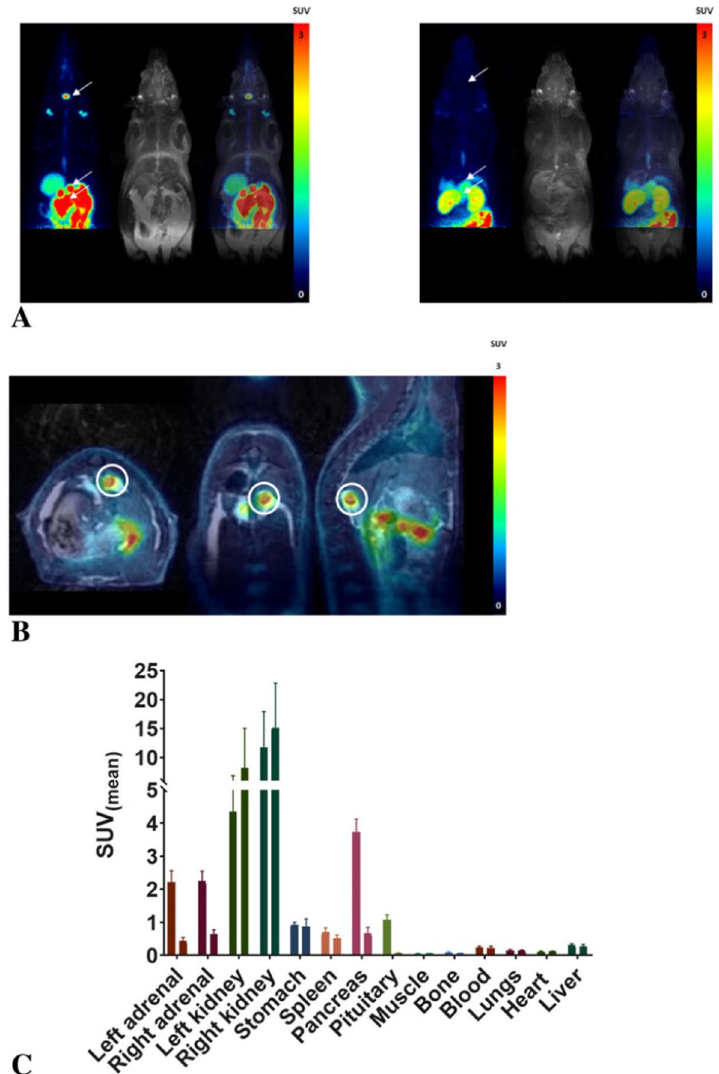
non-clinical testing of radiopharmaceuticals. The use of anatomical information from MRI provides multiparameter longitudinal assessment in a preclinical model ( A : native image (left) and blocked with excess target ligand (right)) with superior mapping of organs B for longitudinal biodistribution/blocking studies and delineation of uptake despite influence from renal excretion. Additionally biodistribution is calculated from the imaging data C (from Tshibangu et al. 2020, legend